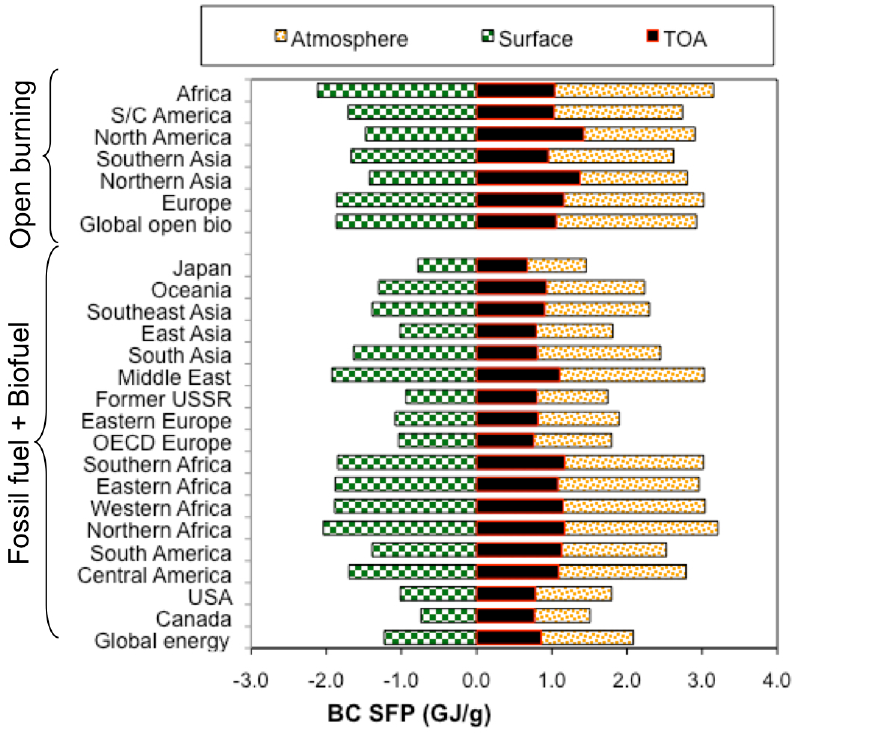
Fig. 6. SFP for black carbon, showing impact on vertical energy balance. Energy is added to atmosphere (orange bars, positive SFP) and removed from surface (green bars, negative SFP). Top of atmosphere value (black bars) is net of surface and atmosphere and is comparable to Fig.